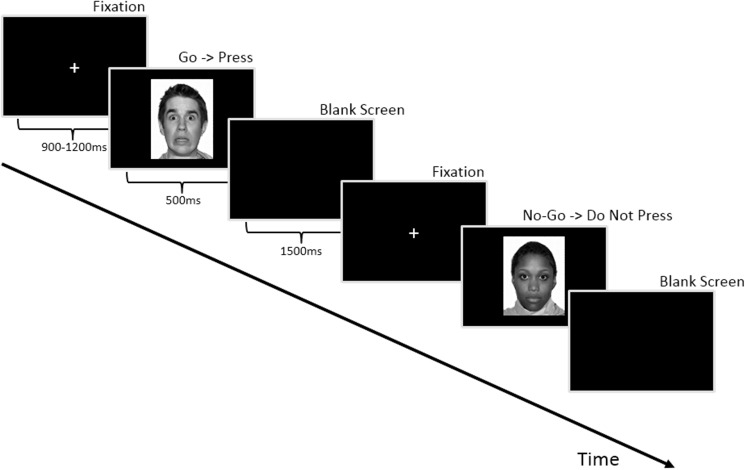
Depiction of an example experimental run.